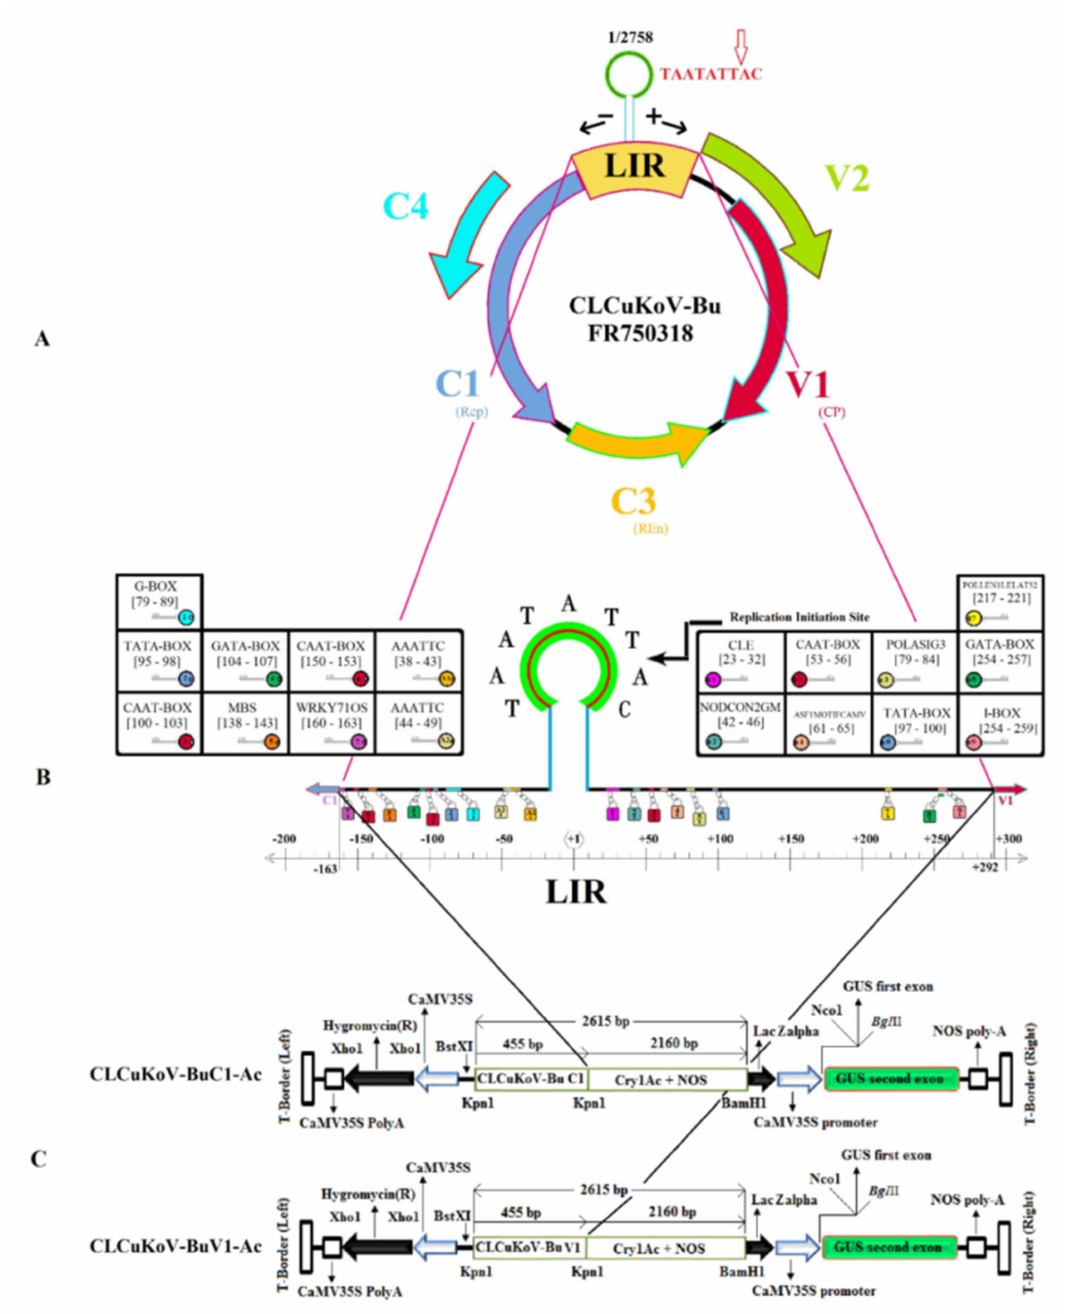
Figure 1. ( A ) Diagram showing the genome organization of CLCuKoV-Bu. The five begomoviral ORFs are indicated by colored arrows. The viral plus strand encodes the V1 and V2 ORFs while the complementary strand encodes three ORFs, C1, C3 and C4. The viral coding regions are separated by a non-coding large intergenic region (LIR) of 455 nucleotides in size. ( B ) Diagram of the LIR shows the predicted regulatory motifs, cis-regulatory elements, transcription factor binding sites, and iteron elements involved in binding the replication-associated protein. ( C ) Map of the Cry1Ac gene expression cassettes under control of the CLCuKoV-BuC1 and CLCuKoV-BuV1 promoters. The Cry1Ac+ NOS was cloned at the restrict site Kpn1-BamH1 in the pCAMBIA1301 plasmid